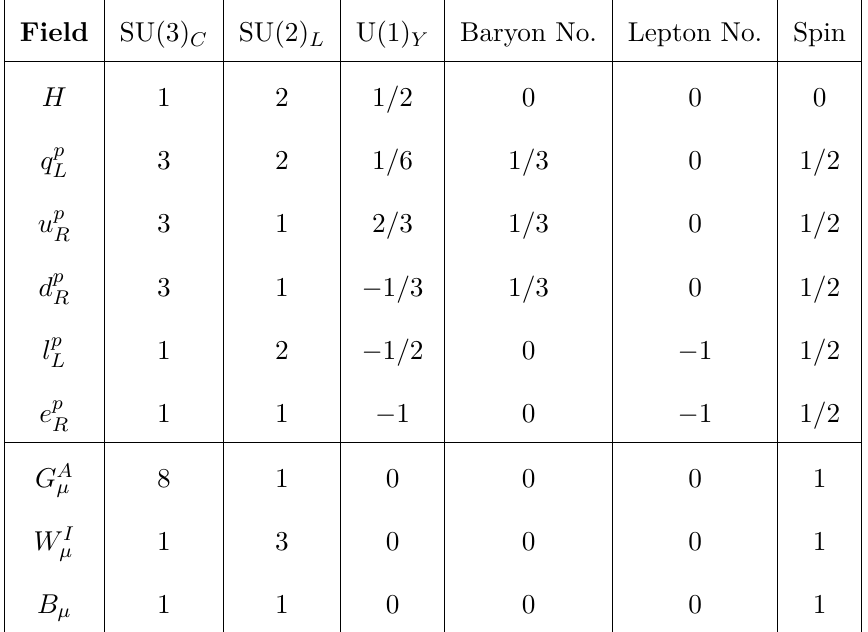
Table 26 . Standard Model: gauge and global quantum numbers and spins of the fields. Here, A = 1 , 2 , · · · , 8 ; I = 1 , 2 , 3; p = 1 , 2 , 3 and µ = 0 , 1 , 2 , 3 refer to the SU(3) , SU(2) , flavour and Lorentz indices